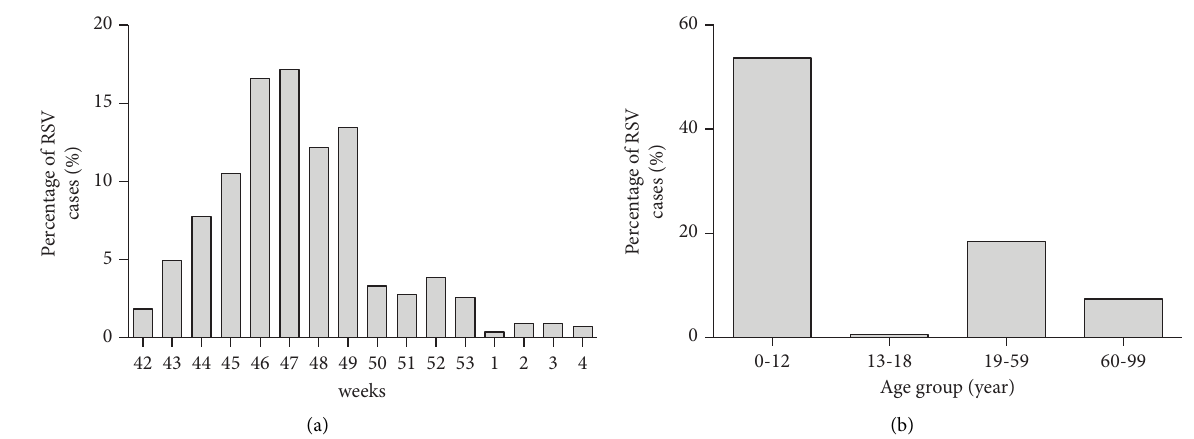
Figure 2: (a) Laboratory-detected cases of RSV during early 2021/2022 season at our center. Vertical bars show percentage of RSV positive specimens identifed by week 42/2021 to 4/2022 (b) Distribution of RSV cases during 2021/2022 season according to age